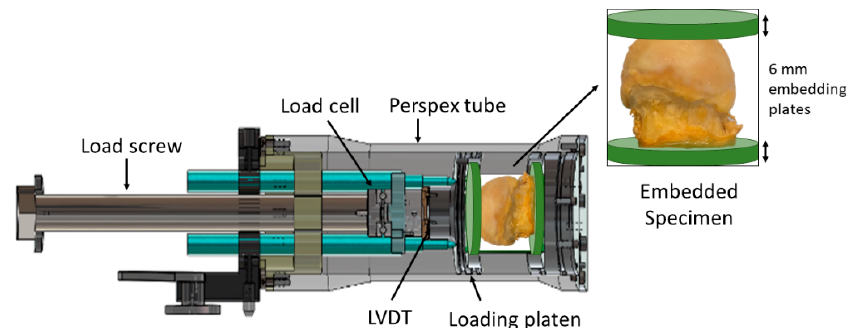
Figure 1. Specimens were embedded in 6mm thick acrylic resin plates, with the top plate created such that it conformed to the rounded surface of the femoral head. The embedded specimens were placed in the mechanical test jig for loading. The loading jig comprised a load screw to apply the compression through a loading platen, a load cell and linear variable displacement transducer (LVDT) to measure applied load in displacement of the loading platen, respectively. The system was encased in a Perspex tube so that it remained visible throughout testing.